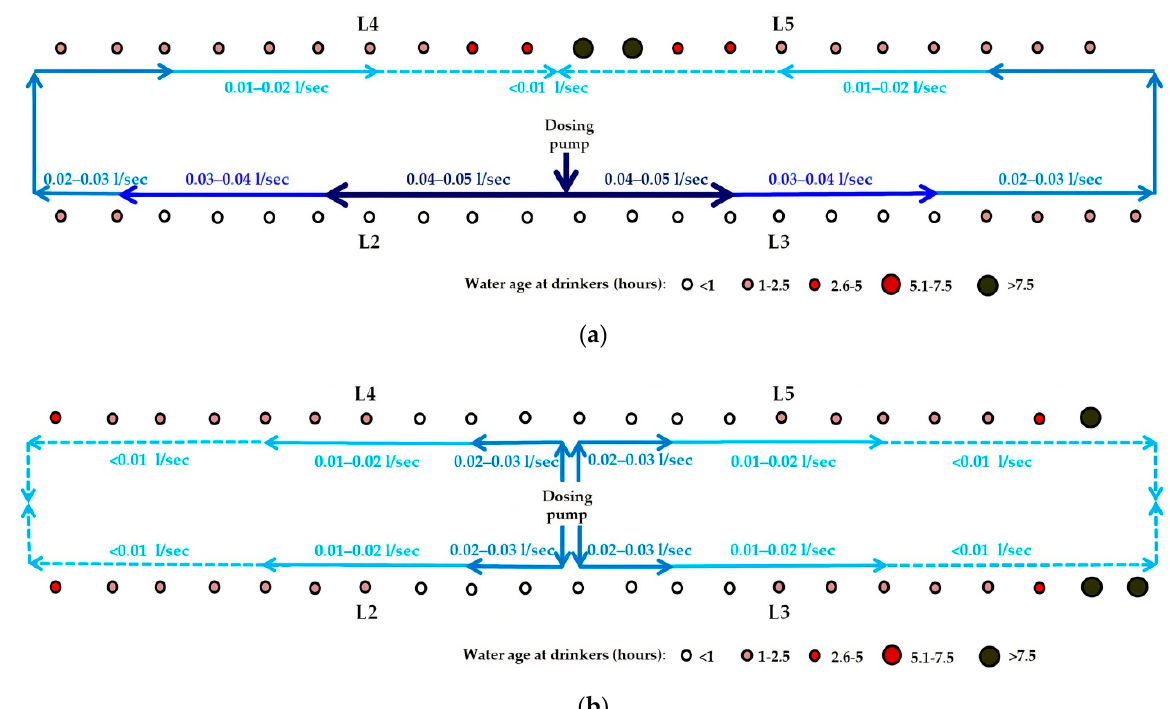
Figure 7. Network maps generated in EPANET, representing the WDSs in Building A at 12:00 noon (day 2) during: ( a ) Study 1a; and ( b ) Study 1b. Coloured arrows indicate the direction of water flow in each pipe section. Water flow rate (L/sec) along each pipe section is indicated by the size of the arrow and thickness of the line. The age of the water (in hours) at each drinker is indicated by the size and colour of the circle.